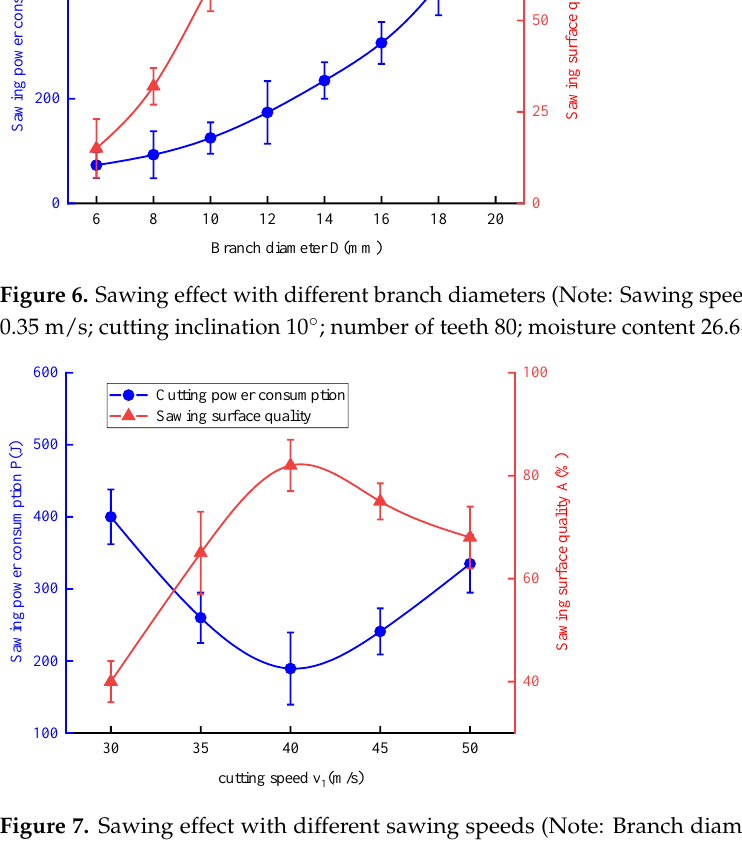
Figure 8. Sawing effect with different feeding speeds ( Note: Branch diameter 10~12 mm; sawing speed 40 m/s; cutting inclination 10°; number of teeth 80; moisture content 24.7~28.3% ).